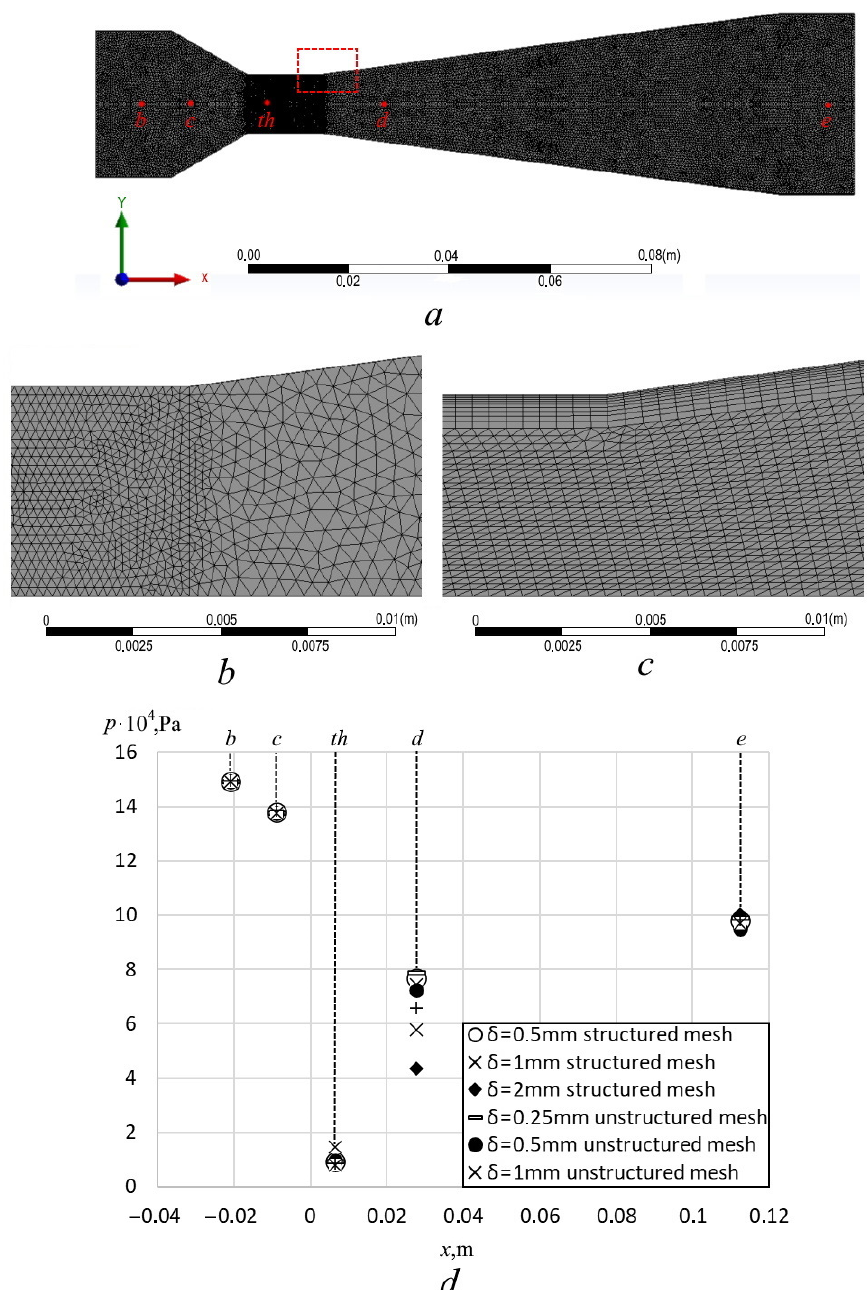
Figure 4. Computational mesh ( a – c ) and mesh study ( d